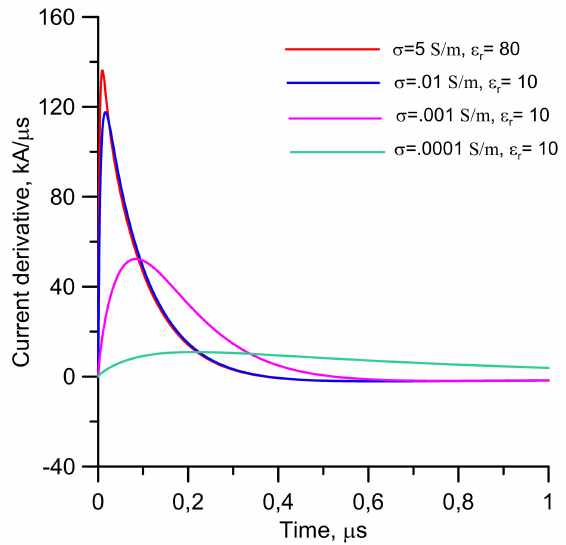
Figure 5. The derivative of the return stroke current at ground level for four values of the soil conductivity at the strike point obtained by assuming that the discharge time constant remains constant along the